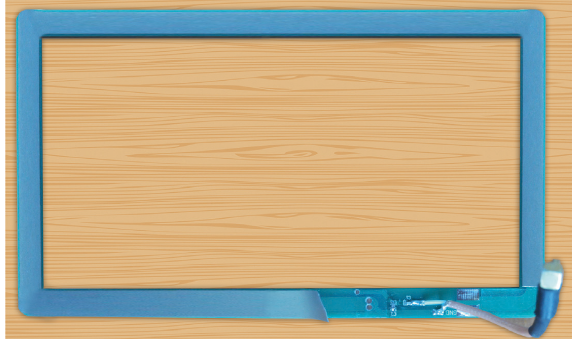
Figure 9: An antenna that completed EMC filtering and imped- ance